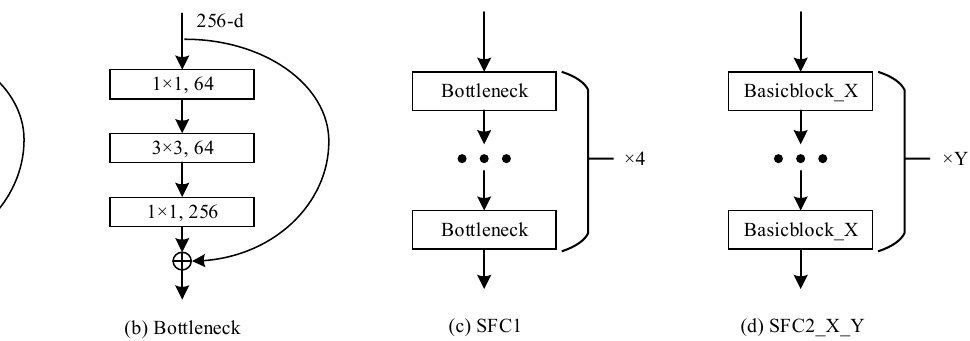
Figure 4. The architectures of two SFC modules. X denotes the channel dimension. Y denotes the number of Basicblock.